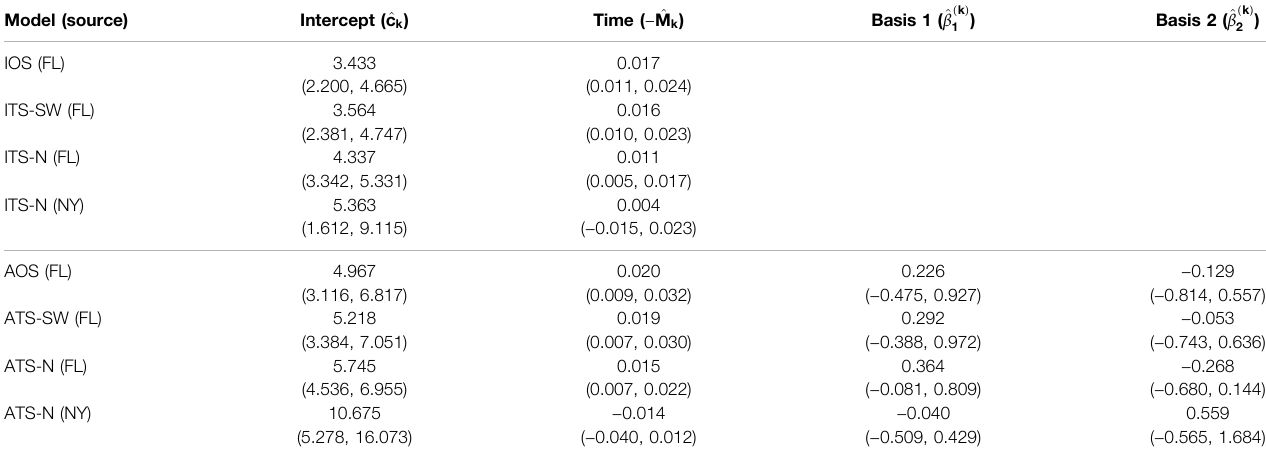
TABLE 5| Parameterestimates and95%con fi dence intervalsforone-and two-sourcemodels fi tto2010data( n (cid:1) 28).Inthetwo-sourcemodels, twosetsofestimatesare reported corresponding to a northern placement and a southwestern placement for the alternate (non-FL) source. No basis parameters are reported for the isotropic models,sincethesetermsareonlyincludedintheanisotropicmodels.Inthisyear,noalternatesourcemodelisestimated forthesouthwestlocation,asnearlyalldatapoints are attributed to the FL source during model fi tting (FL - Florida, TX - Texas, OH -